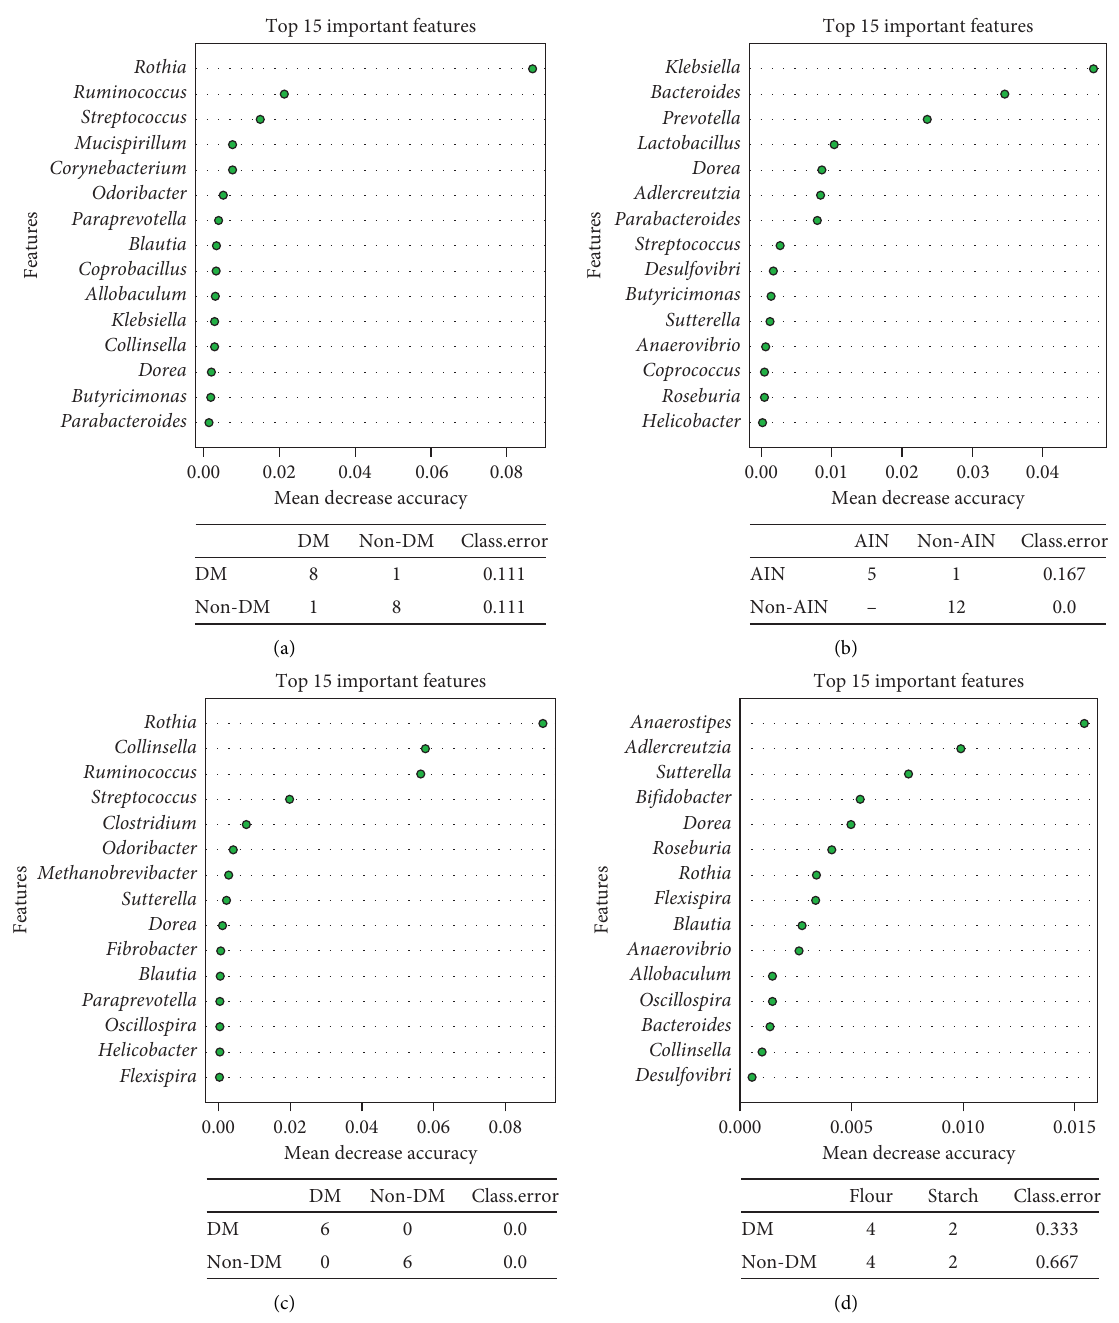
Figure 6: Random Forest prediction (run in METAGENassist) of samples in week 4 belonging to either DM or non-DM rats (a) and AIN- or taro-fed (non-AIN) rats (b). (c) Prediction of DM and non-DM of taro-fed rats only. (d) Prediction of starch-fed or flour-fed rats. The top 15 markers are shown. Of these, the top 10 have been plotted in Figure 5 (together with markers identified by LEfSe and Kruskal–Wallis correlation). Table 2: Concentrations ( μ mol/g wet weight; mean ± SD) of acetate, propionate, and butyrate in fecal pellets at week 4.